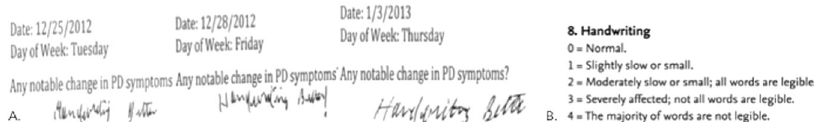
Fig. 1 Subjective assessment. An example of participant-reported improvement in handwriting and the subjective nature of dysgraphia assessment using Uni fi ed Parkinson ’ s Disease Rating Scale (UPDRS) as an outcome measure. a . Journal entry from the Phase I/II a study